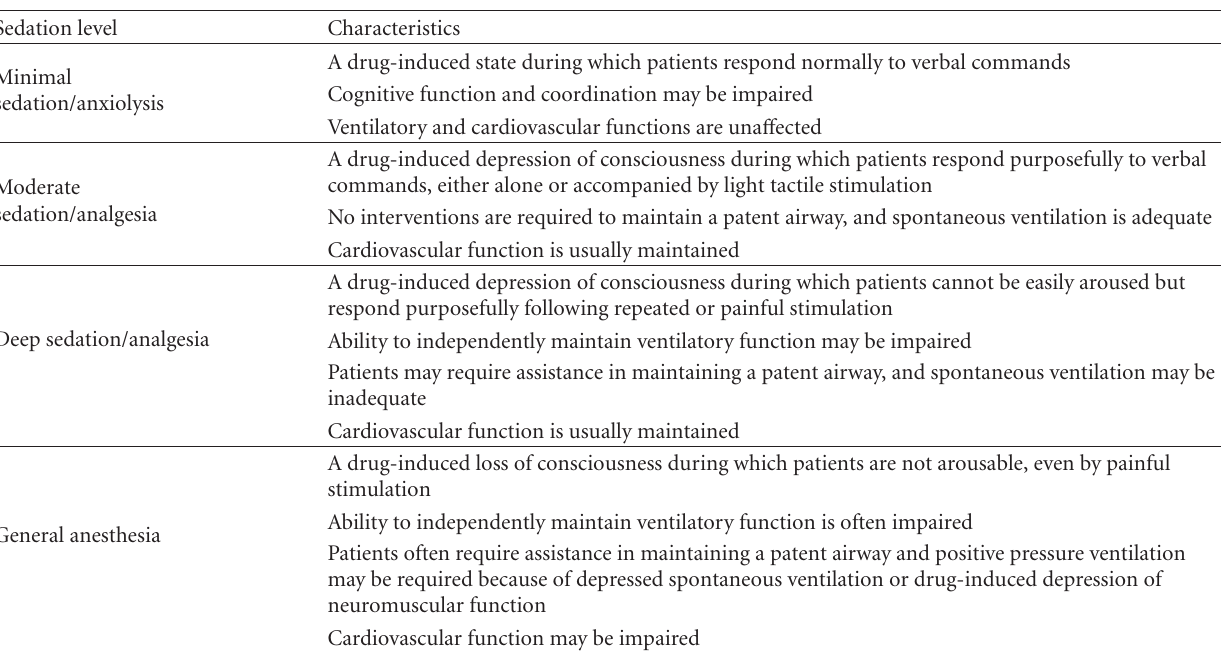
Table 1: Definitions of clinical states of sedation as proposed by the American Society of Anesthesiologist’s task force on sedation and analgesia by nonanesthesiologists